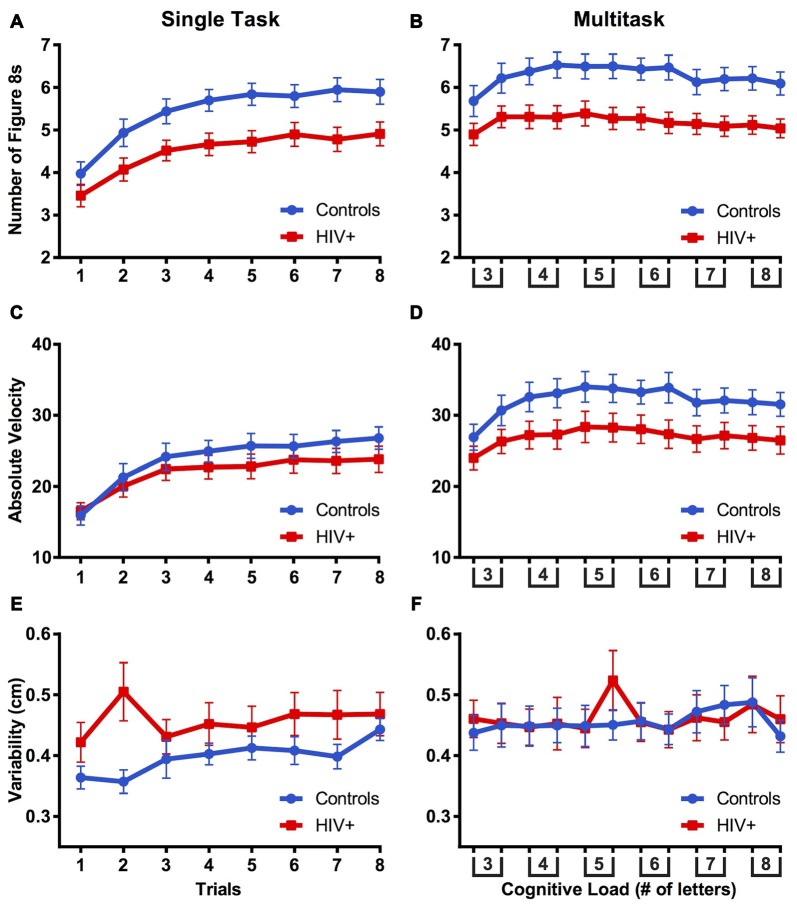
The mean number of figure 8s drawn (A,B), mean velocity (C,D), and mean variability (E,F) between controls and HIV+ participants compared across single and multitasks phases. Error bars represent standard error of the mean.